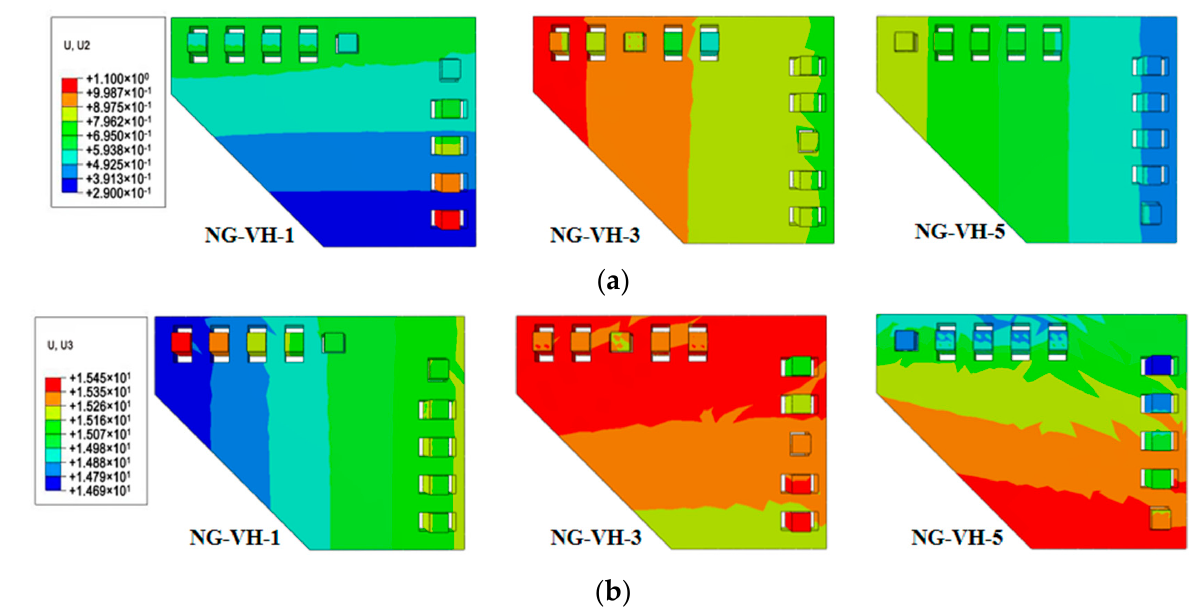
Figure 15. The ( a ) vertical and ( b ) horizontal displacement contours of specimens NG-VH-1, NG-VH-3 and NG-VH-5.